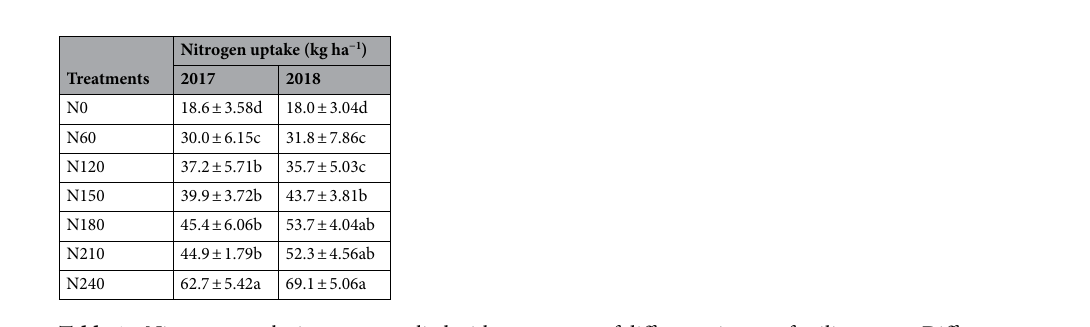
Table 1. Nitrogen uptake in potato applied with treatments of different nitrogen fertilizer rates. Different letters indicate significant differences (P < 0.05) among treatments in the same year.